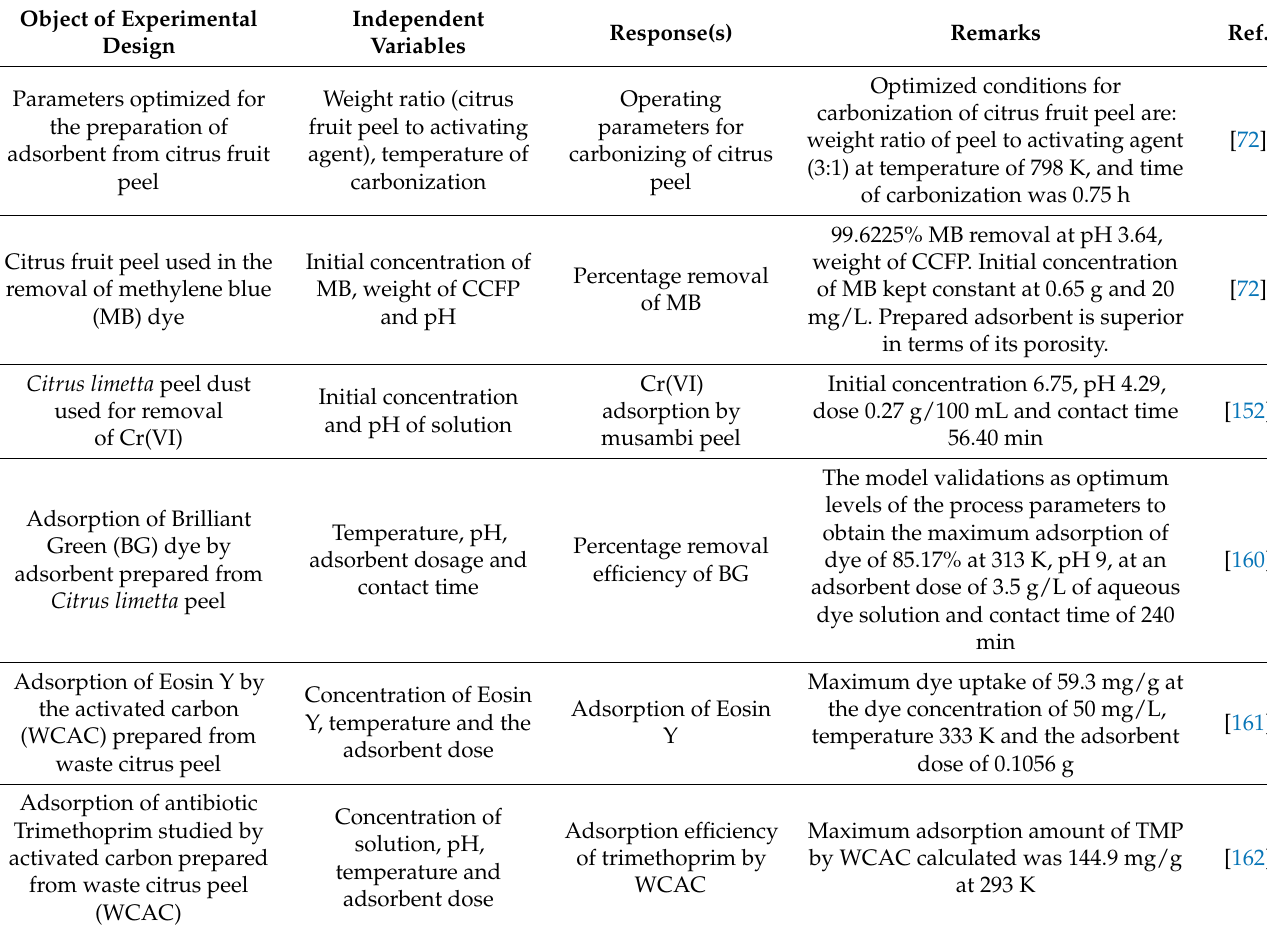
Table 6. Applications of RSM in the bio-sorption